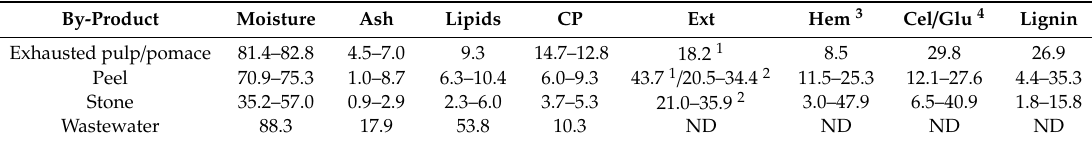
Table 1. Moisture (%, fresh weight) and chemical composition of some avocado residues (%, dry weight) [12,20,27,29–33]. By-Product Moisture Ash